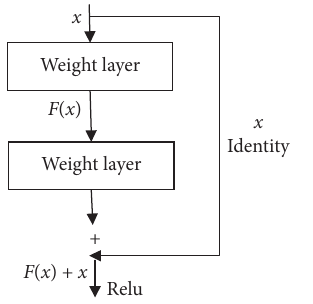
Figure 3: Residual model: a building block. Table 2: The architecture of ResNet-34 and